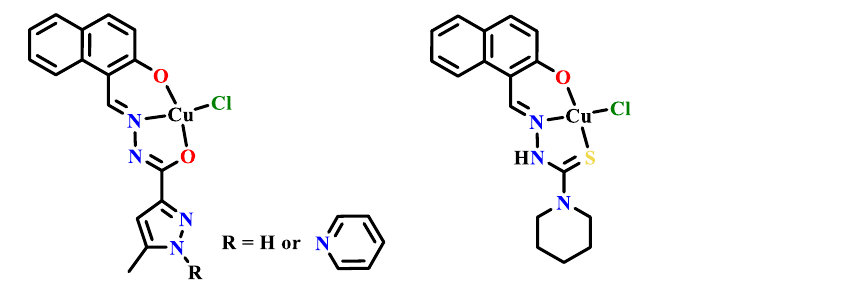
Figure 22. Different Cu(II) complexes of naphthylhydrazone with imidazolamide or piperidinyl thiourea as side chains.